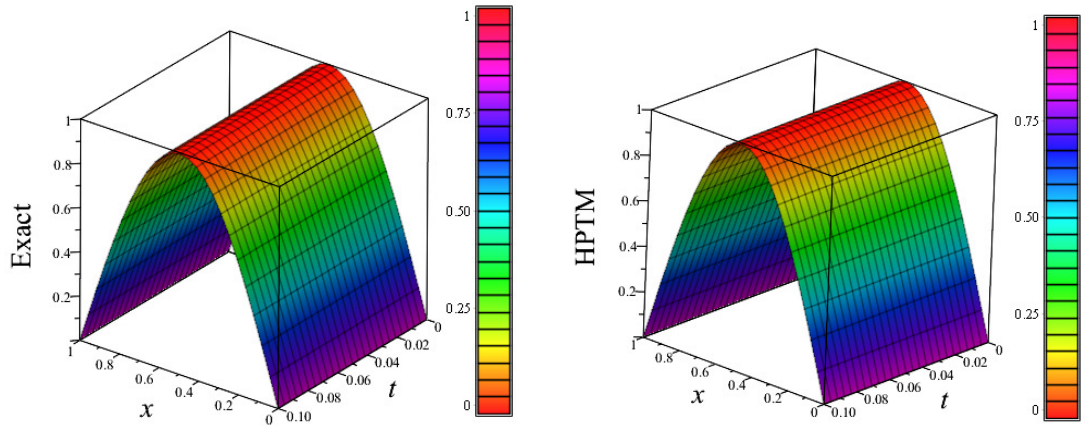
Figure 9. 3D plots of exact solution and approximate solution using HPTM, vs. x vs. t , for numerical experiment